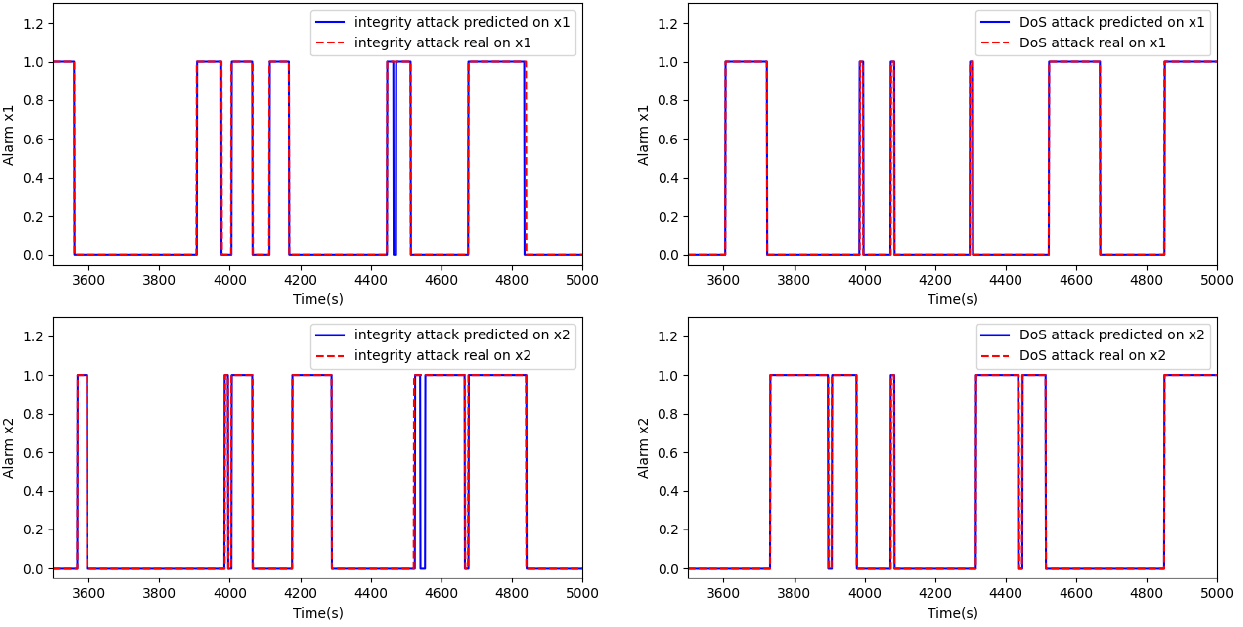
Figure 18. Alarm generation.